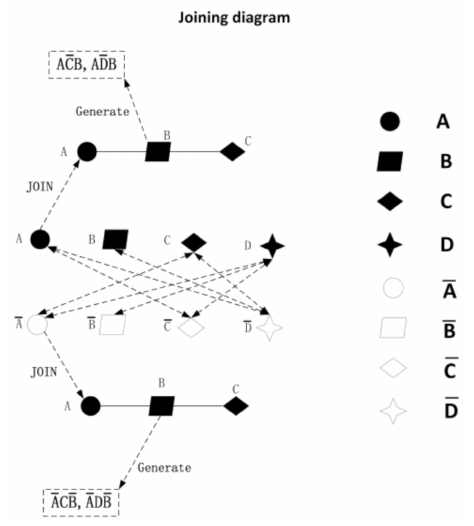
Figure 2. Join-based algorithm with a connect